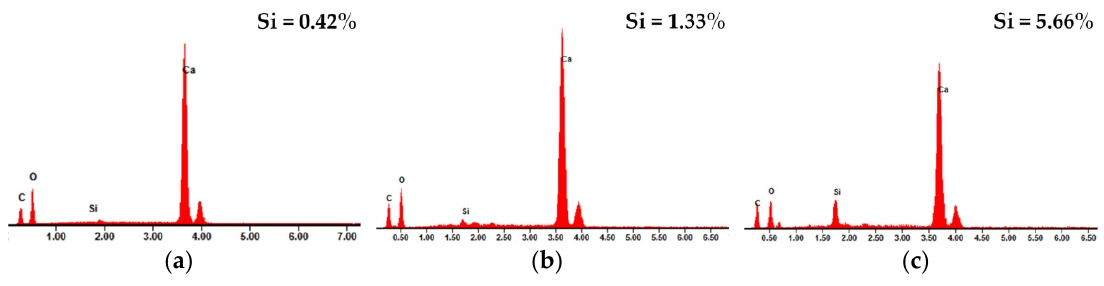
Figure 3. ESEM images: ( a ) Surface of T 5 ; ( b ) Area indicated in (a) at higher magnification. Figure 4. EDS spectra acquired on ( a ) the untreated stone, ( b ) the surface of T 2.5 samples, and ( c ) the surface of T 5 samples. In each spectrum, the Si quantification (measured as wt %) is indicated.